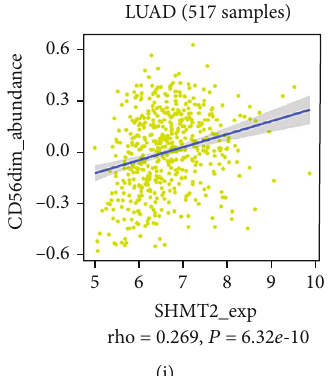
Figure 10: Relations between the abundance of tumor-in fi ltrating lymphocytes (TILs) and SHMT2 expression, including (a) Type 1 T helper cell, (b) nature killer cell, (c) T follicular helper cell, (d) active B cell, (e) immature B cell, (f) active CD4 T cell, (g) Type 17 T helper cell, (h) Tem CD8, and (i) CD56 dim nature killer